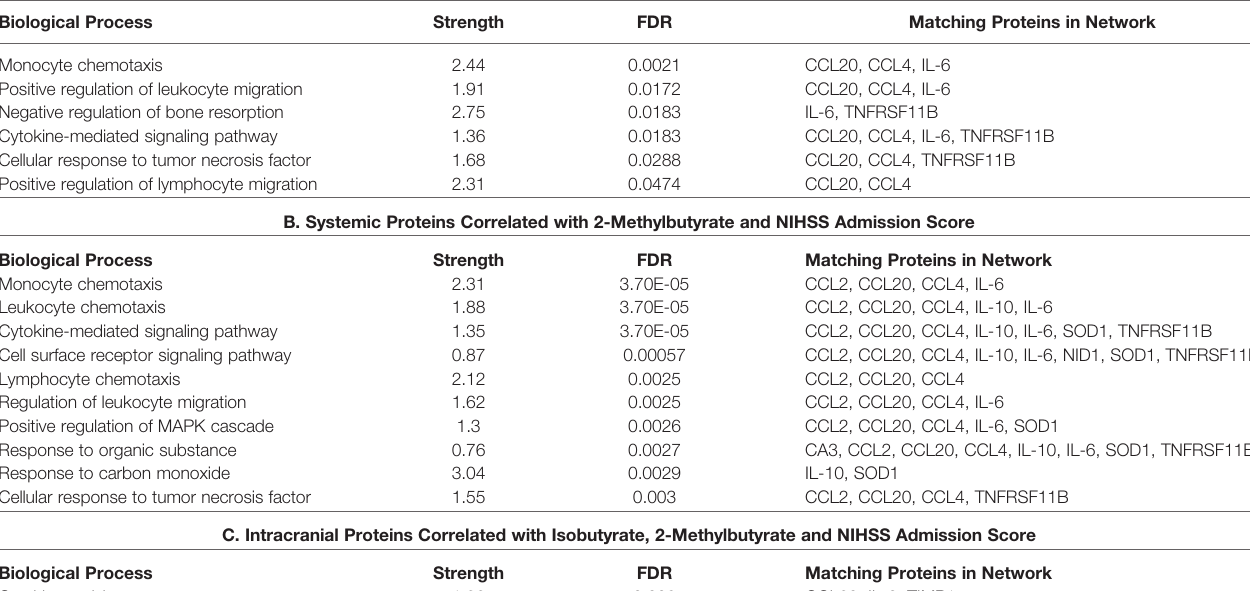
TABLE 7 | Biological processes associated with STRING networks for systemic proteins correlated with both Isobutyrate and NIHSS admission scores (a), systemic proteins correlated with both 2-methylbutyrate and NIHSS admission scores (b) and intracranial proteins correlated with Isobutyrate, 2-methylbutyrate and NIHSS admission scores (c).